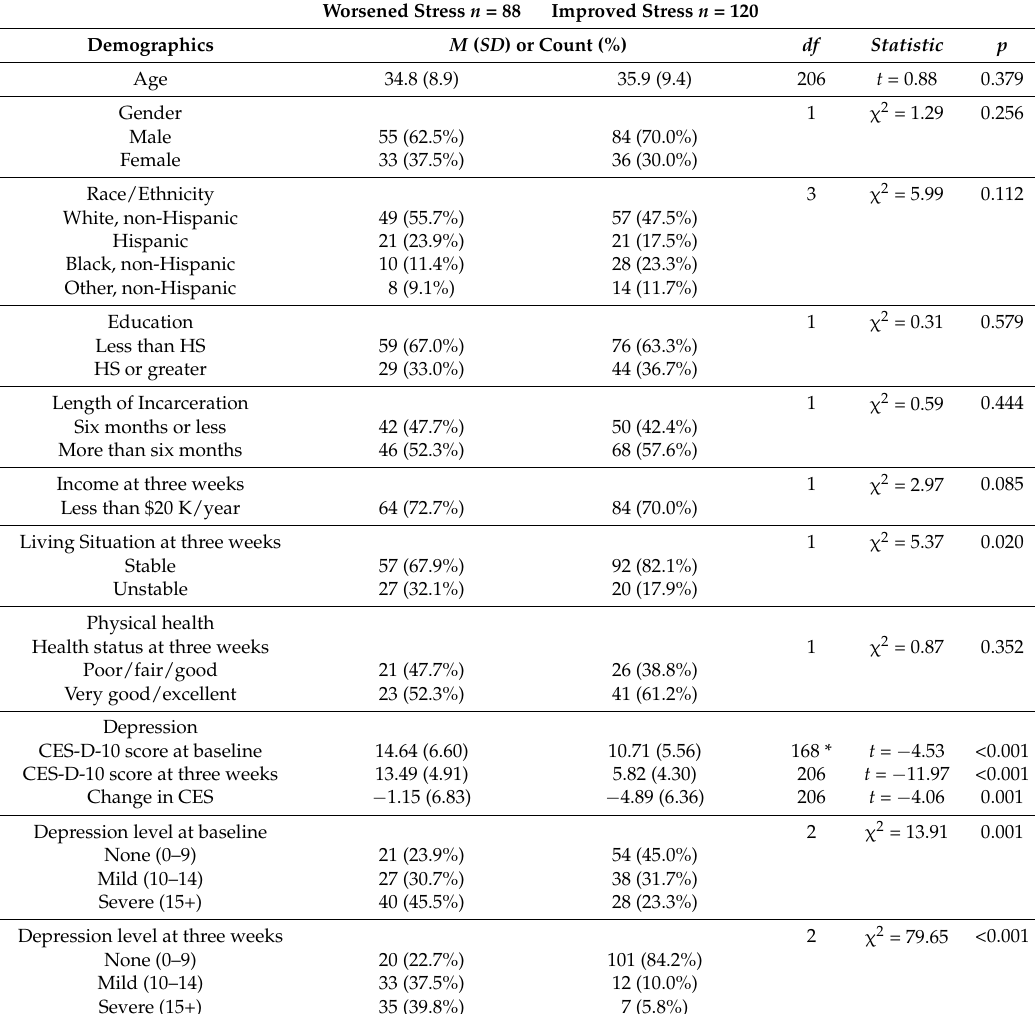
Table 2. Descriptive statistics and group difference analyses between those who worsened and those who improved in stress levels from baseline to